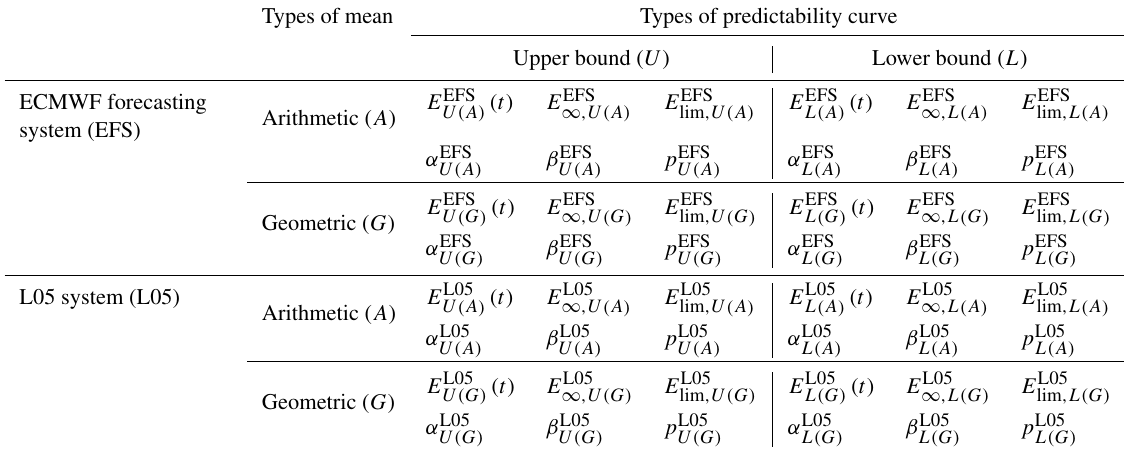
Table 1. Description of symbols that indicate types of predictability curve, types of mean and systems for prediction error E , theoretically calculated limit error E ∞ , and parameters of error growth models α , β , p , and E lim (Eqs. 8–13).